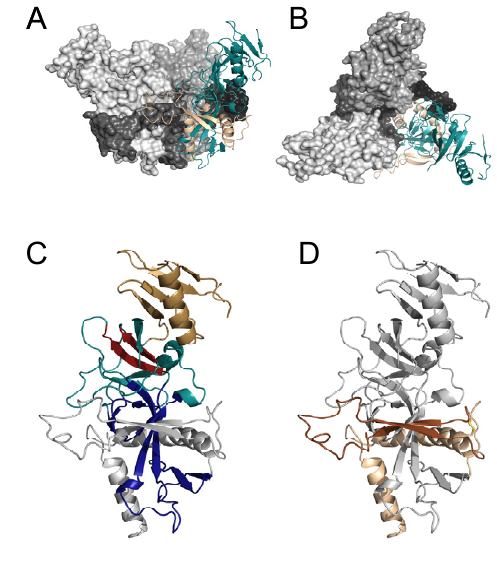
Figure 1. Structure of the pre-fusion EBOV GP. ( A , B ) Structure of the trimer. Side view of the EBOV GP trimer is shown in A. Top-down view of the EBOV GP trimer is in B. Two of the three trimers are shown as space filling structures with GP in lighter grey and 1 GP as dark grey/black. The third GP heterodimer of the trimer is depicted as a ribbon 2 1,2 structure with GP shown in teal and the GP subunit shown in tan. ( C , D ) Ribbon diagrams 1 2 of a single heterodimer of GP . Domains in GP are highlighted in C, whereas domains in 1,2 1 GP are highlighted in D. In panel C, the base domain of GP that interacts with GP is 2 1 2 shown in royal blue, the head domain is shown in teal with the beta-strands and adjacent loop region containing the RBS highlighted in red and the glycan cap is shown in gold. GP is shown in grey. In panel D, the internal fusion loop (IFL) that is flanked by 2 beta-strands is shown in dark brown and heptad repeat region 1 is shown in tan. The interaction of the IFL with GP residues from an adjacent subunit is evident in panel A. All 1 EBOV GP graphics (PDB accession number 3CSY) were produced with